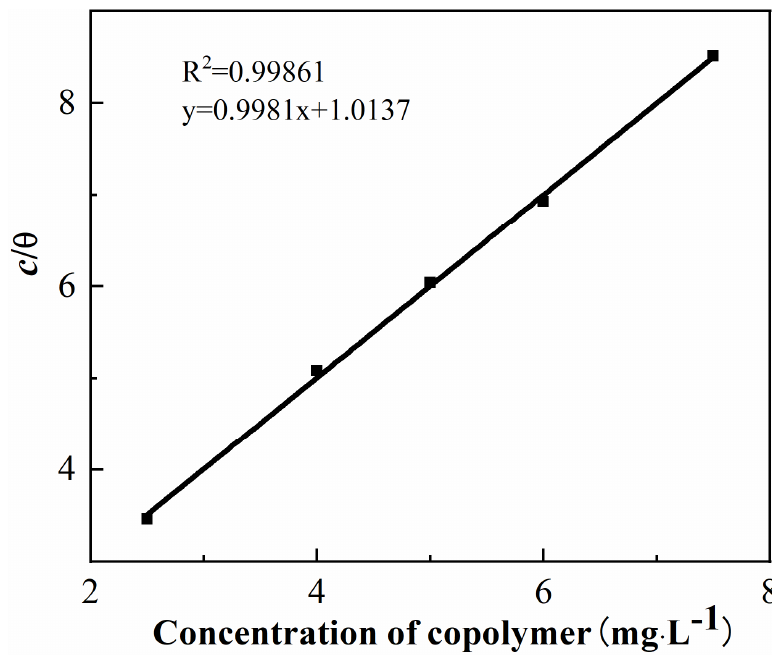
Figure 13. Adsorption isotherm .